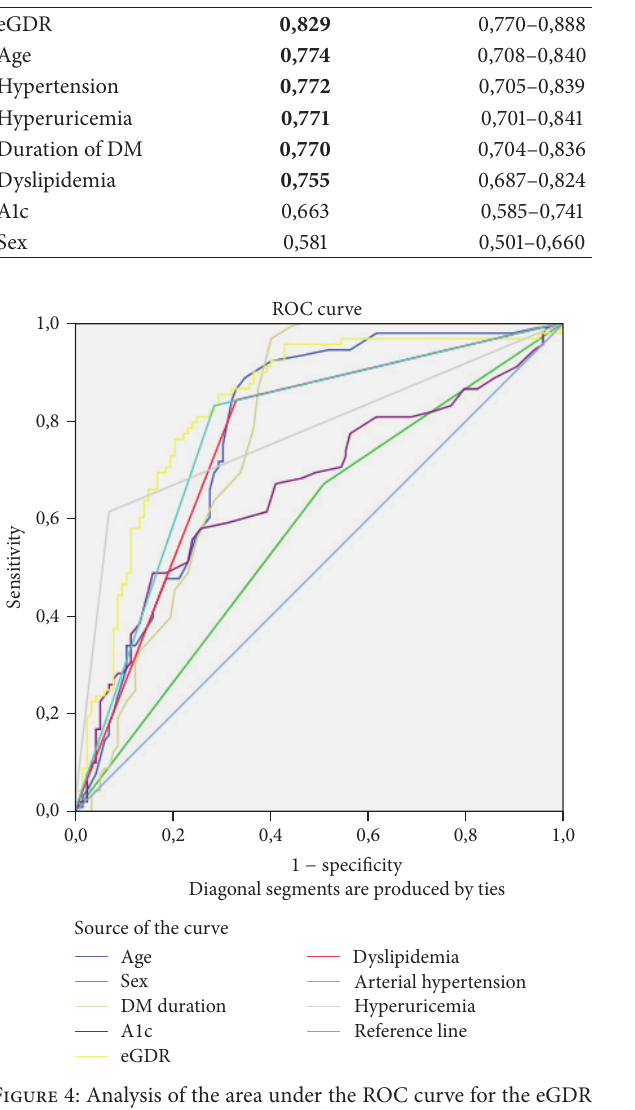
Figure 4: Analysis of the area under the ROC curve for the eGDR in patients with